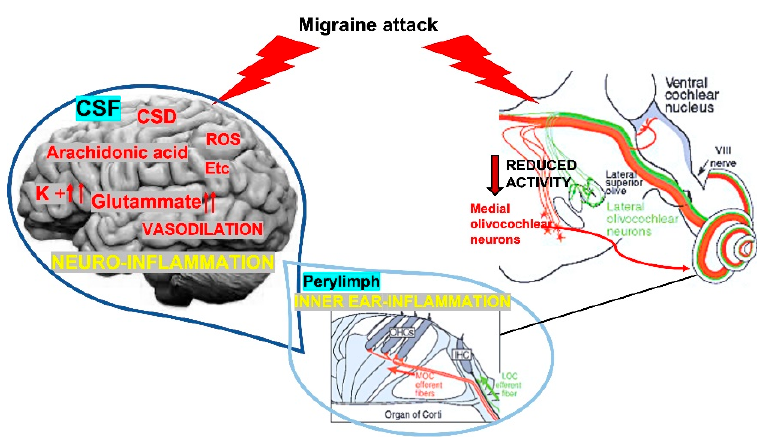
Figure 3. The image summarizes our hypotheses. In case of increase of pro-inflammatory cytokines, the elements migrate from brain into the inner ear through the liquid exchange between cerebrospinal fluid (CSF) and perilymph (left side of the image). Several components (Reactive Oxygen Species—ROS—, cortical spreading depression—CSD—, K+ increase, glutamate increase, arachidonic acid, vasodilation, etc.) induce an inflammation with consequent hypofunction of the inner ear cells. On the right side, the suppression of MOC activity affects the inner ear cells motility. In both cases, DPOAE will be reduced as we identified in our study.